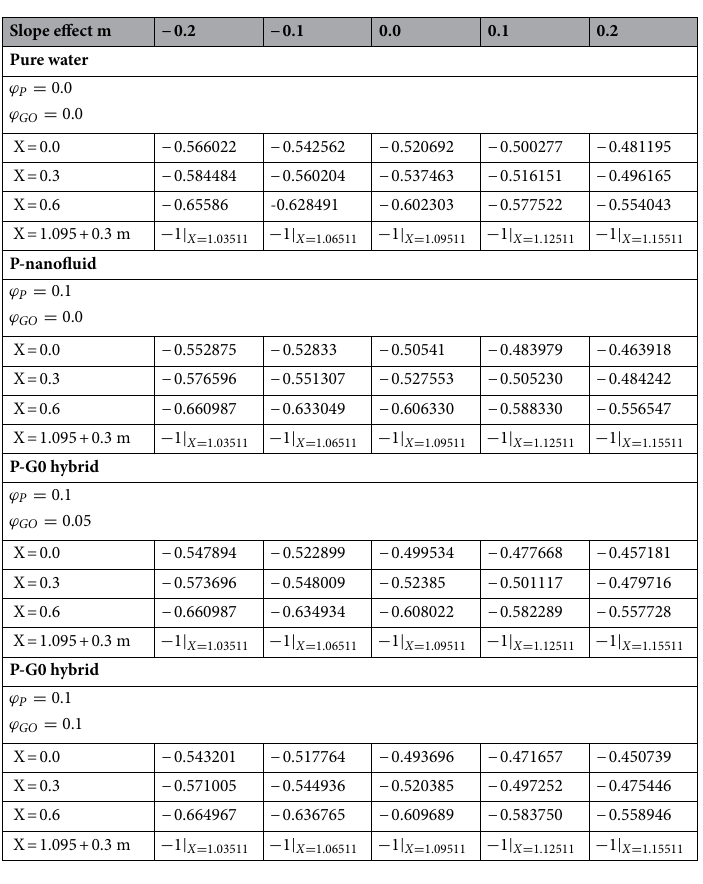
Table 4. Velocity field variation for convergent/uniform/divergent channel effect analysis on P/water nanofluid, P-GO/water hybrid nanofluid keeping M = 3, Q = 0.3, ϕ = 0.1 values